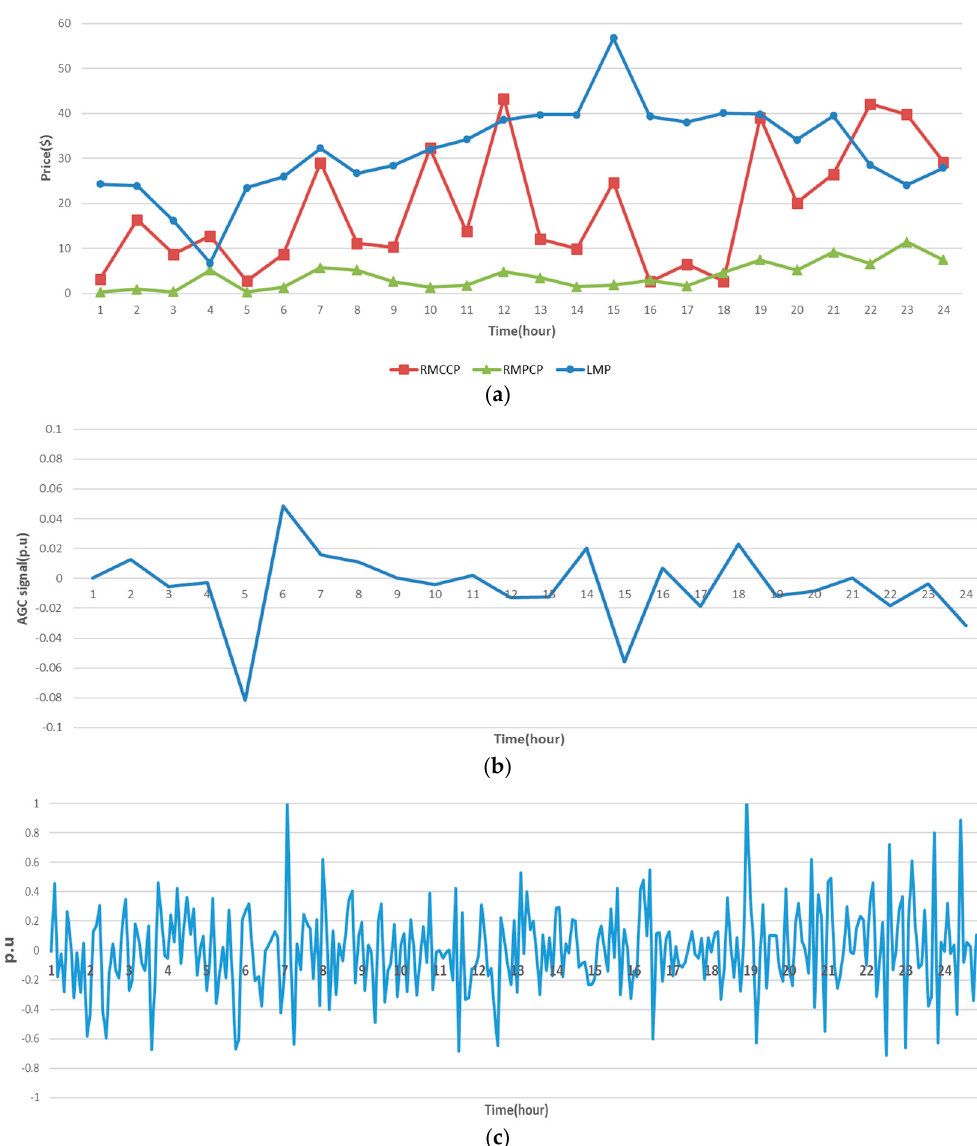
Figure 2. Actual market data in PJM ( a ) hourly market price; ( b ) hourly averaged AGC signal; and ( c ) AGC signal. RMCCP : regulation market capability clearing price; RMPCP : regulation market performance clearing price; and LMP : locational marginal pricing.